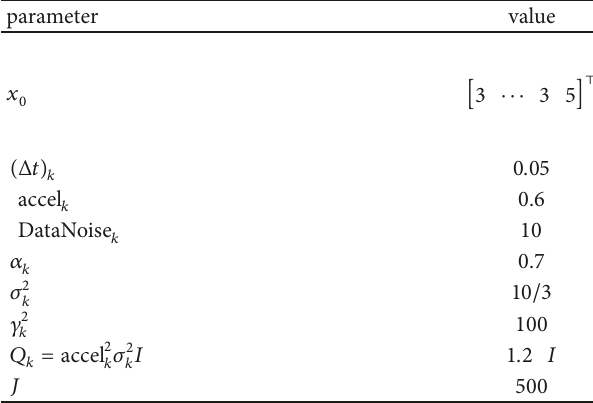
Table 1: Experiment